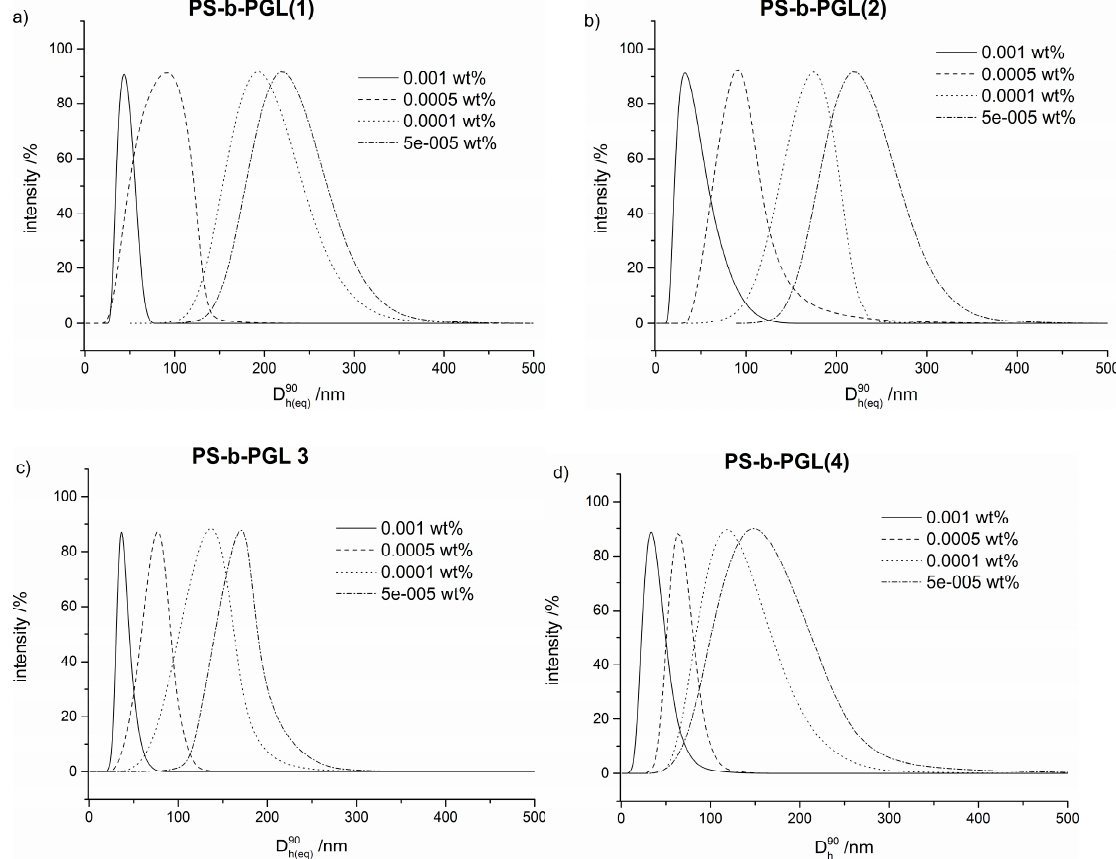
Figure 5. Particles size distributions for ( a ) PS- b -PGL(1), ( b ) PS- b -PGL(2), ( c ) PS- b -PGL(3), ( d ) PS- b - PGL(4) copolymers of various initial concentrations in dioxane/water 50/50 solution.